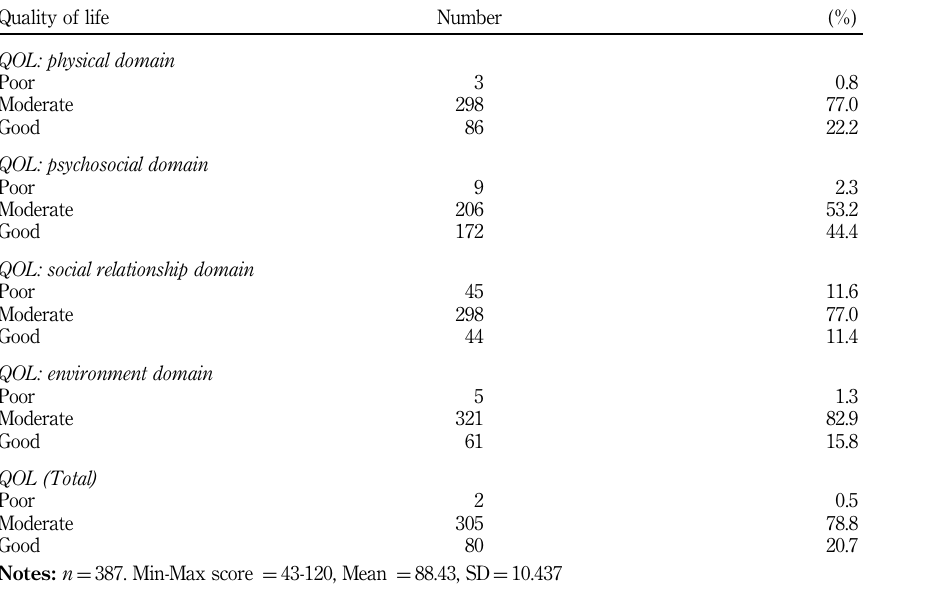
Table II. Quality of